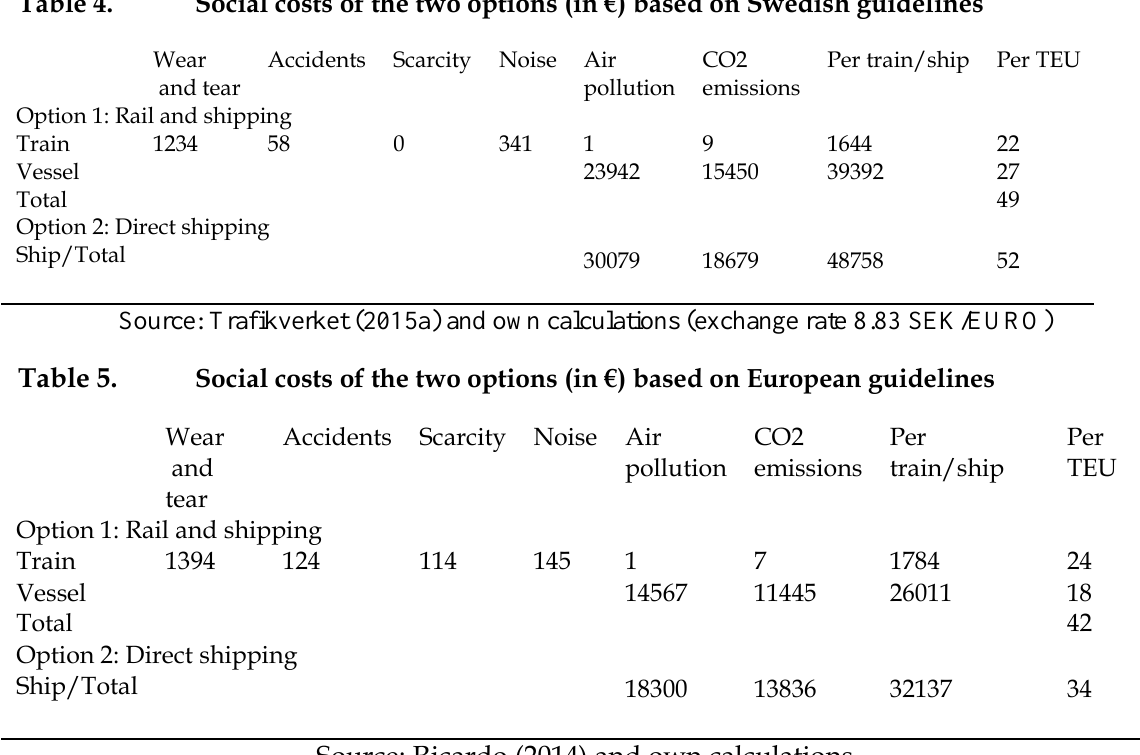
CO2 Per train/ship Per TEU pollution emissions